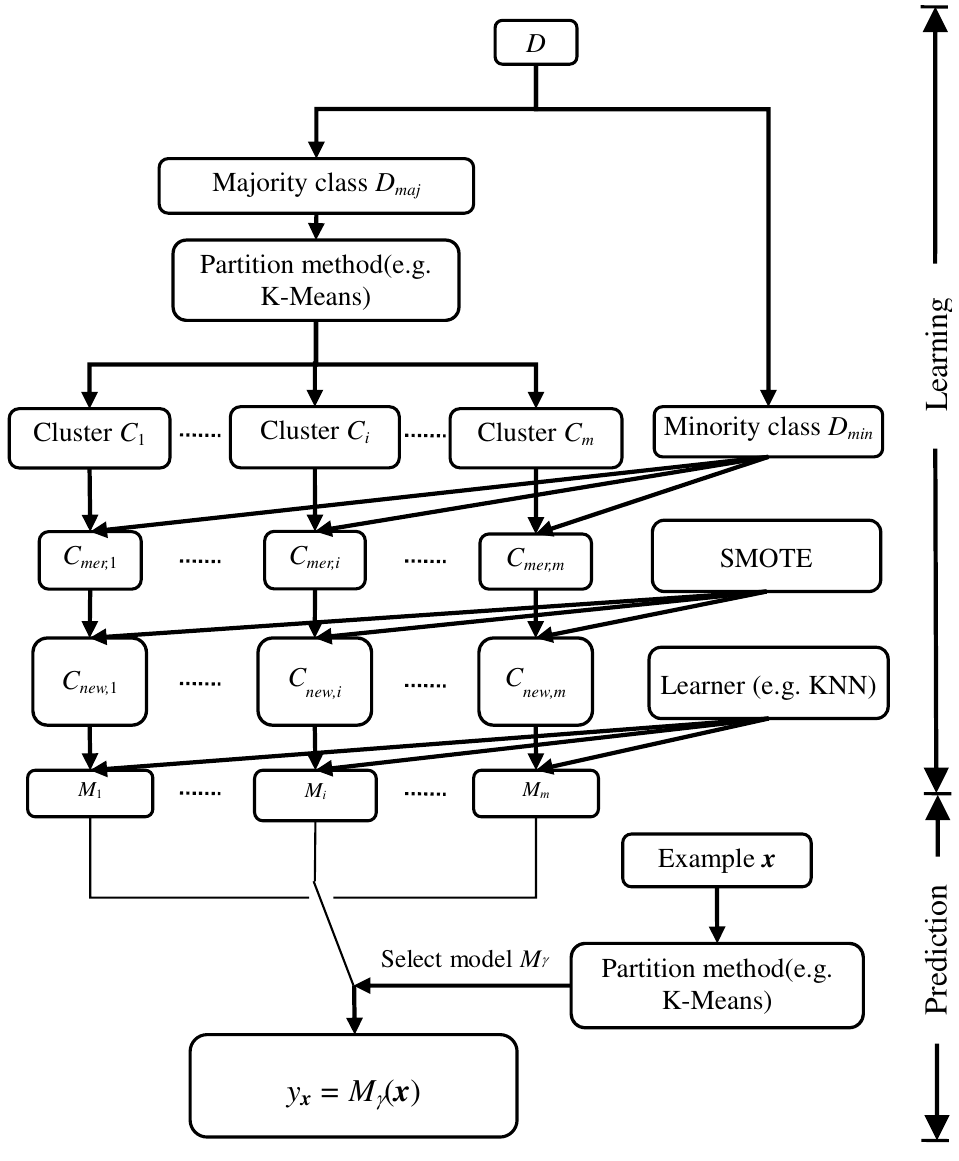
Figure 2. Diagram of the proposed